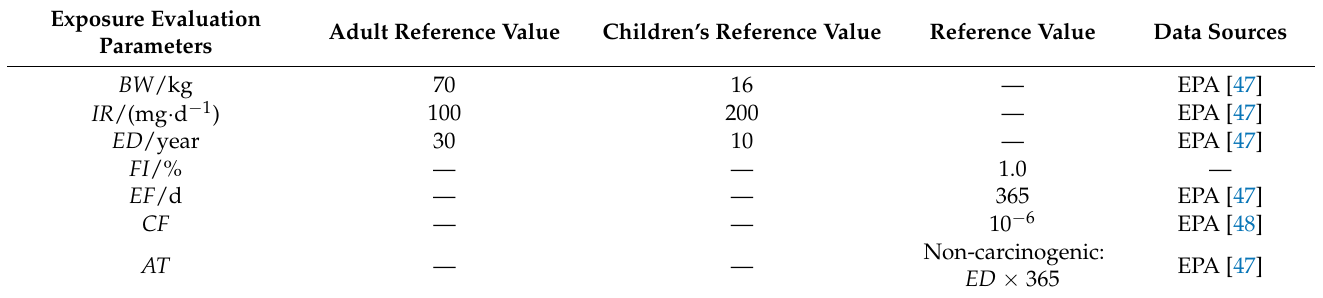
Table 3. Parameters of the exposure assessment